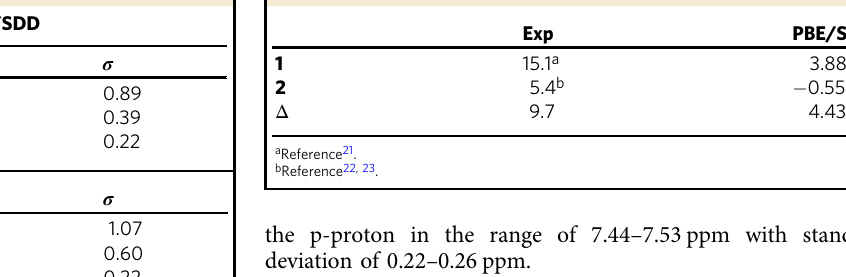
Table 2 Experimental and DFT 1 H NMR chemical shift δ in ppm of the core-hydrogen in clusters 1 and 2 (PBE